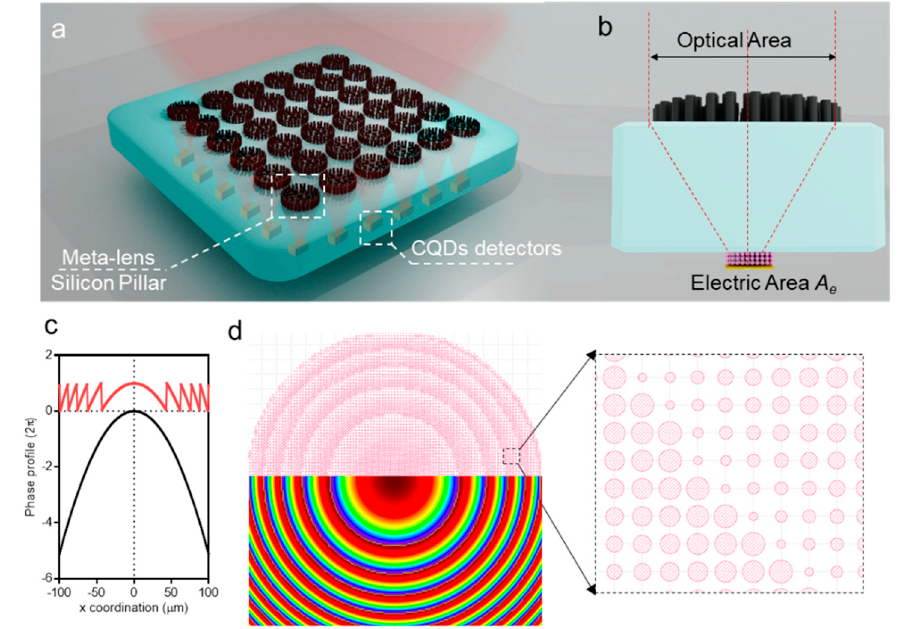
Figure 2. ( a ) Illustration of meta-lens integrated with CQD detectors. Incident light is collected and focused into CQD detectors with a small electric area. ( b ) Cross-sectional illustration of the meta-lens integrated with the CQD detector. Light illuminated onto the optical area is focused to the CQD detector with electric area A e . ( c ) Phase profile of a regular lens (black curve) and meta-lens (red). ( d ) Design of meta-lens using pillar structures. The diameter and focal length are 200 and 200 μ m, respectively. Inset is a representative 2D phase mapping used to generate the meta-lens design.